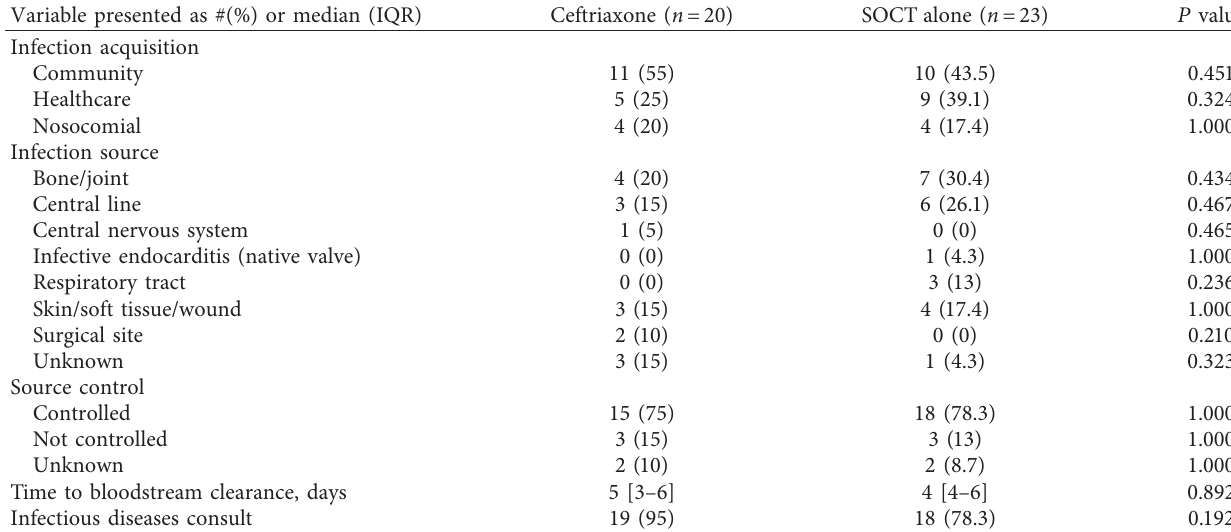
Table 2: Infection characteristics.